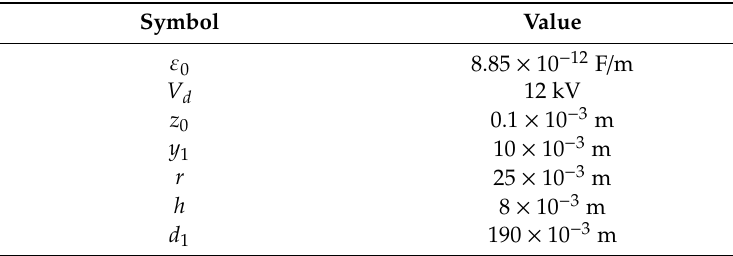
Table 1. Parameters for electrostatic force calculation.